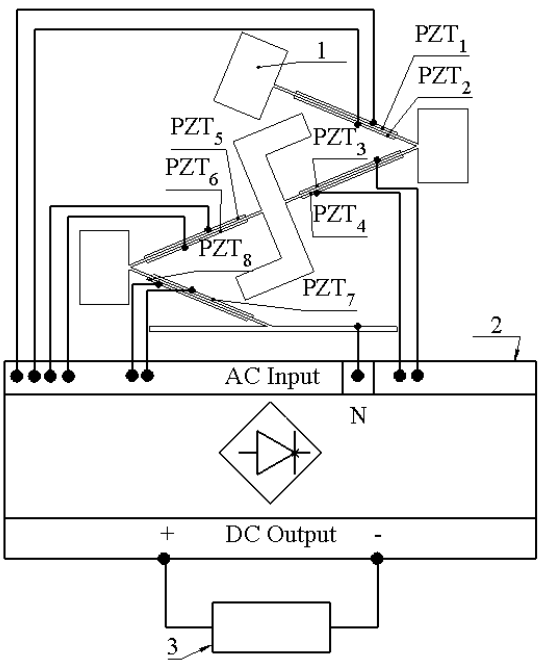
Figure 2. Basic electrical diagram of electrical connections; 1—the energy harvester; 2—multi-channel AC/DC converter; 3—resistive load; PZT 1 –PZT 8 —piezoelectric ceramics.